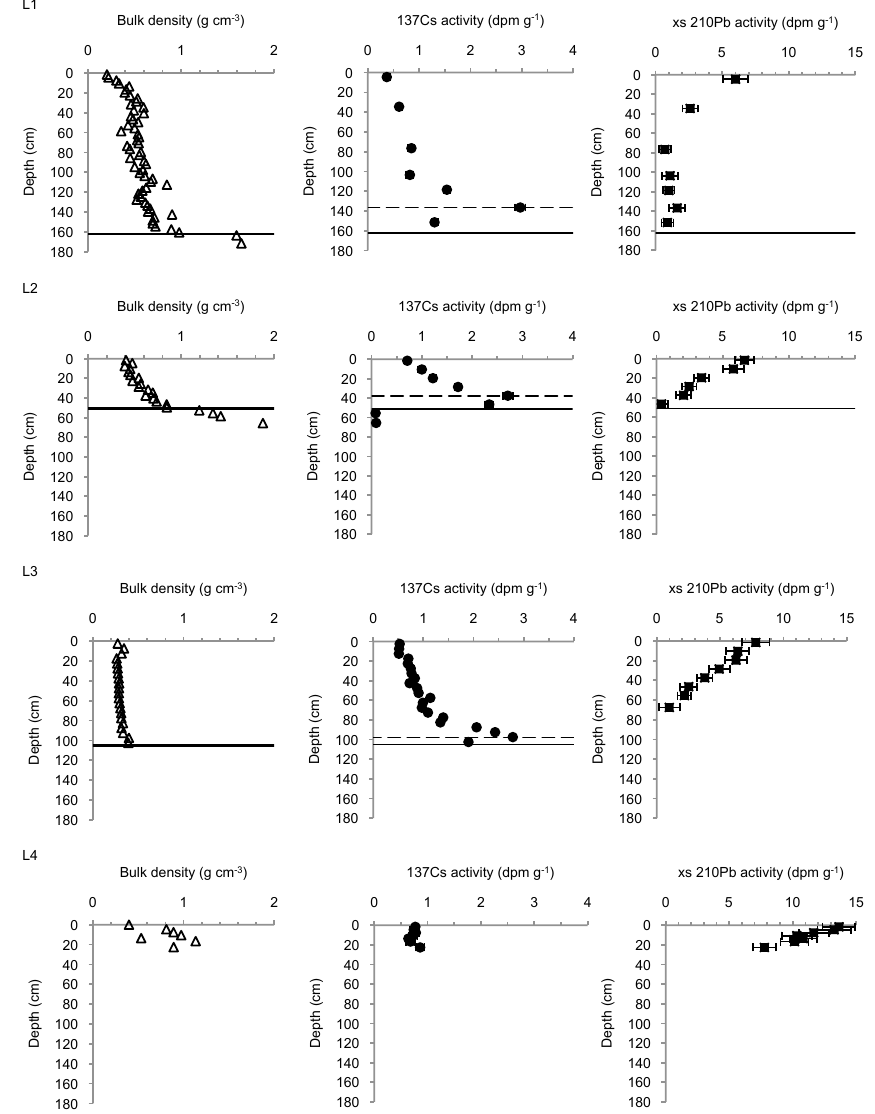
Figure 6. Sediment core profiles of bulk density and radioisotope activities from the eight reservoirs. Solid horizontal lines indicate the pre-impoundment surface (no line indicates the core did not capture the pre-impoundment surface). Dashed lines in 137 Cs graphs represent the depth of peak activity. The 210 Pb profile for L3 is from a second core collected at the same